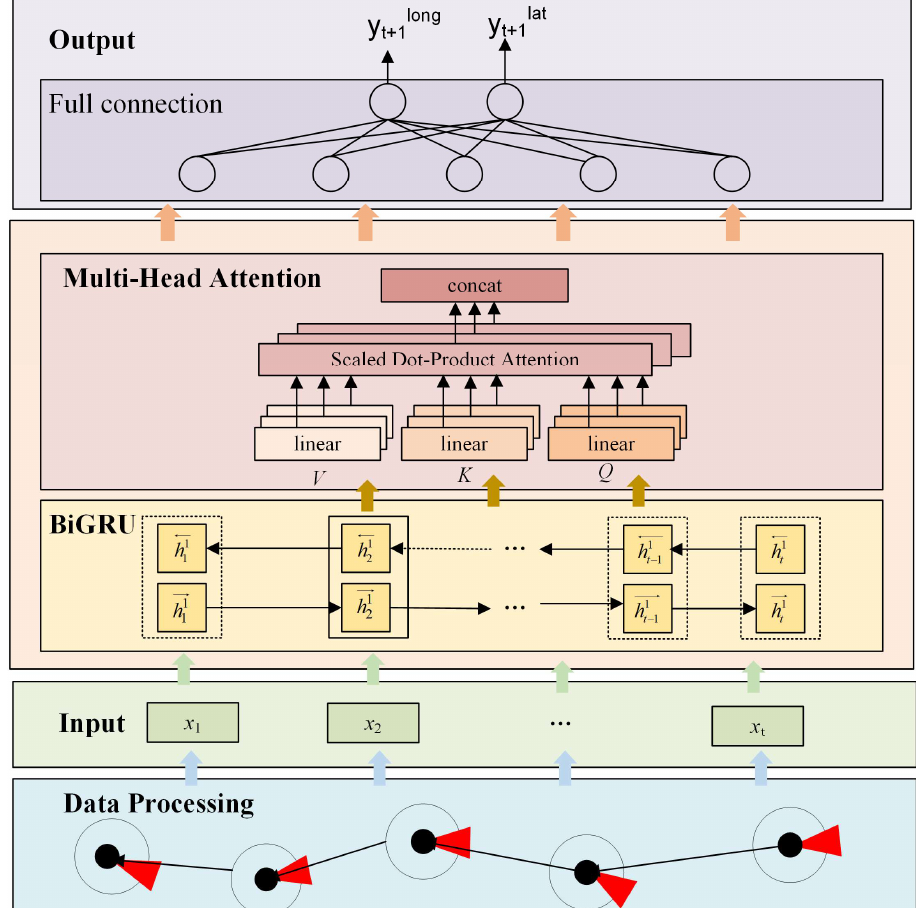
Figure 4. Schematic diagram of the MHA-BiGRU.